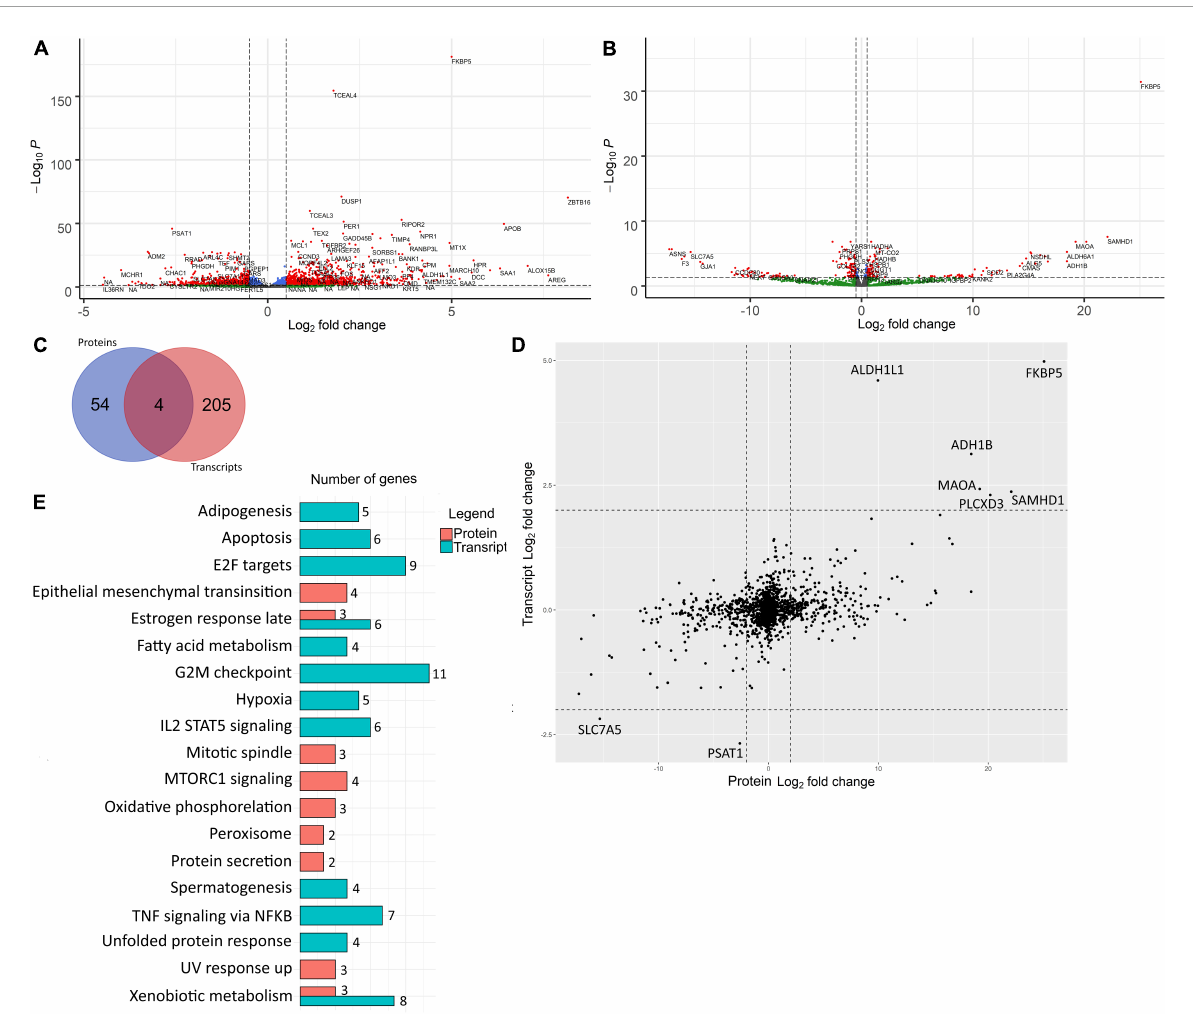
FIGURE2 Differentially expressed genes involved in osteogenic differentiation of human valve interstitial cells (VIC) from healthy and calcified valves were identified by transcriptomics and proteomics analysis at early and late time points respectively. (A) Volcano plot of RNA-seq analysis of control VIC and 48 h after induction of osteogenic differentiation. Log 2 fold change—level of change in expression-Log10P—logarithm of P -value. Dotted lines cut off transcripts with P -value < 0.05 and Log 2 fold change > |1|. (B) Volcano plot of proteomics analysis of control VIC and 10 days after induction of osteogenic differentiation Log 2 fold change—level of change in expression-Log 10 P—logarithm of P -value. Dotted lines cut off transcripts with P -value < 0.05 and Log 2 fold change > |1|. (C) Venn diagram representing overlapping of DEGs with Log 2 fold change > |2| between control and differentiated VIC founded in proteomic and transcriptomic data. (D) Scatter plot of comparison of Log 2 Fold Change of genes identified in both proteomic and transcriptomic data. The dotted line separates the border of Log 2 fold change > |1|. (E) Bar chart representing the number of DEGs with Log 2 fold change > |2| found in proteomic and transcriptomic involved in biological processes based on their overlapping with information in Hallmark gene sets in MSigDB database. All represented overlaps have FDR q-values less than